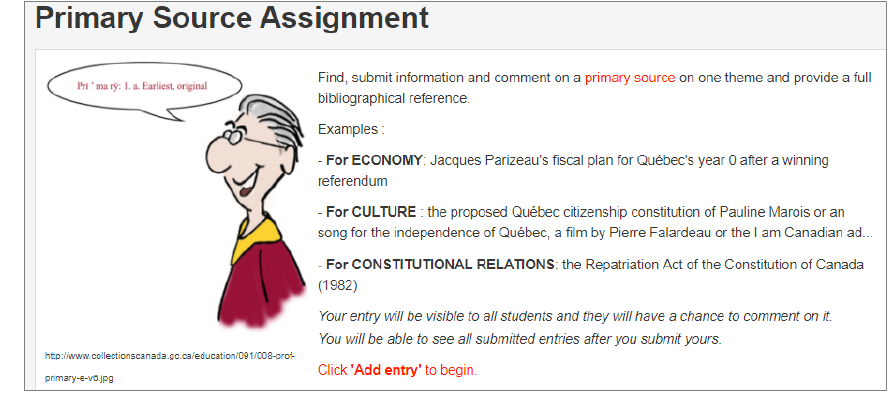
Figure 3 . Primary source assignment instructions.